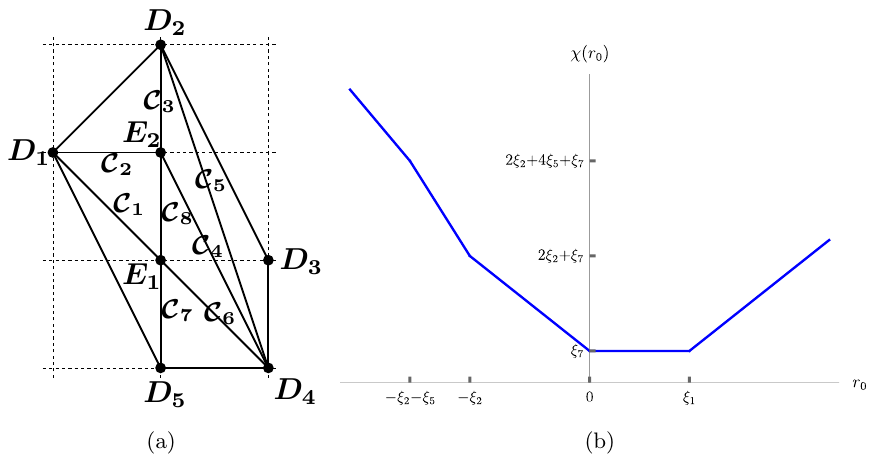
Figure 25 . Resolution (d) of the E 22 ; 1 2 singularity and its vertical